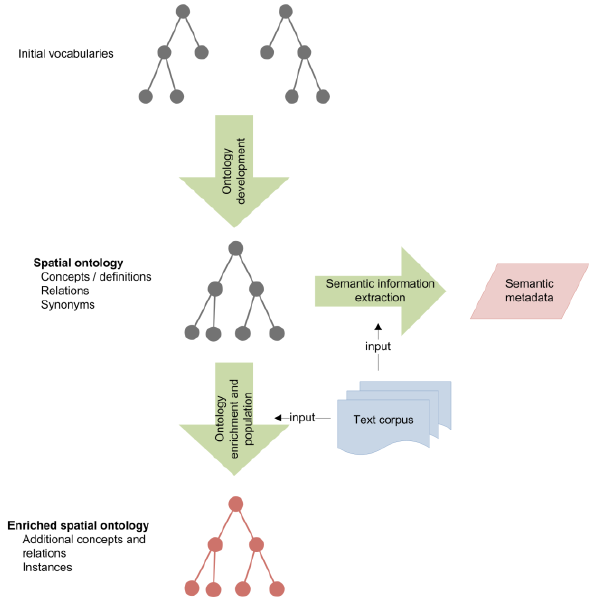
Figure 1. Workflow of the proposed